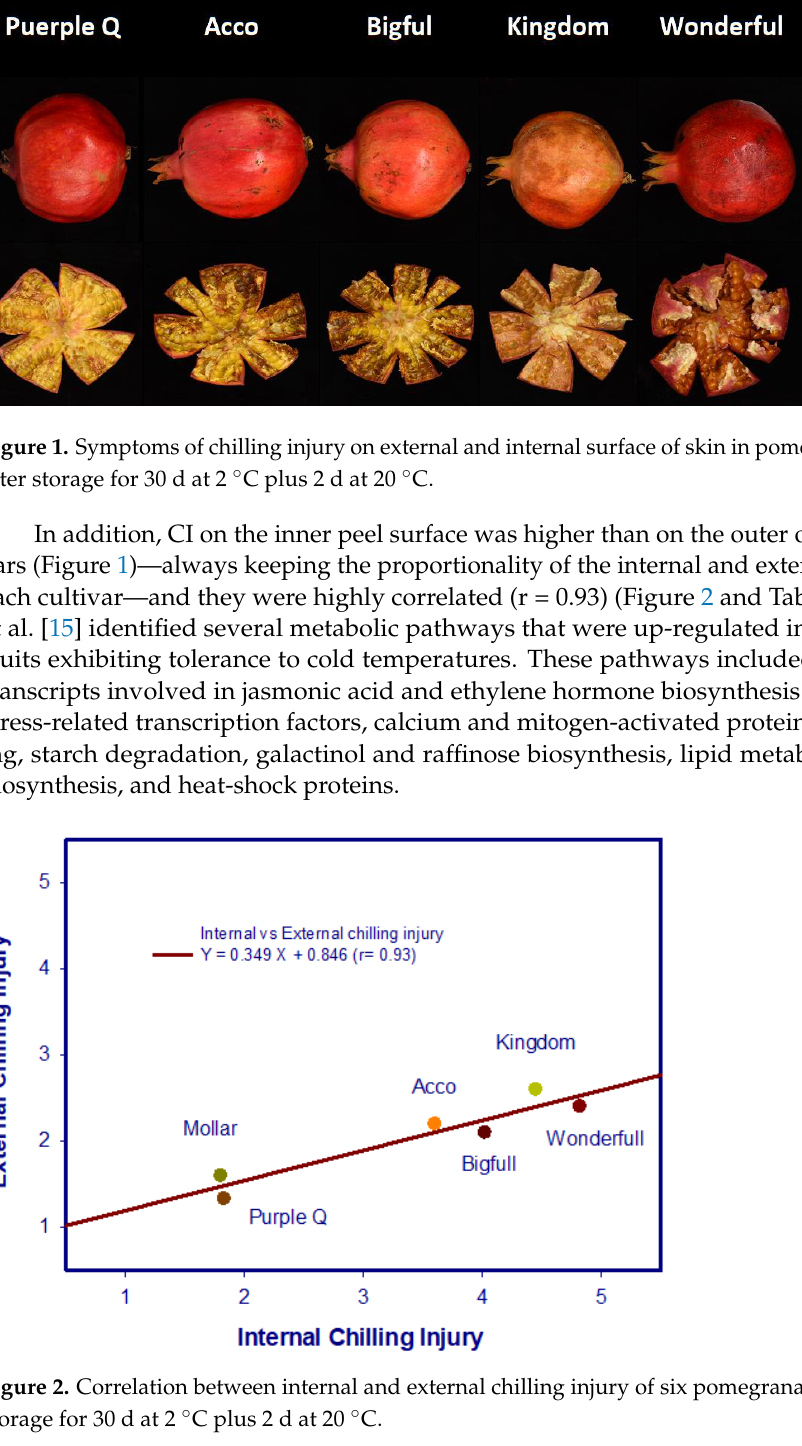
Figure 2. Correlation between internal and external chilling injury of six pomegranate cultivars after storage for 30 d at 2 ◦ C plus 2 d at 20 ◦